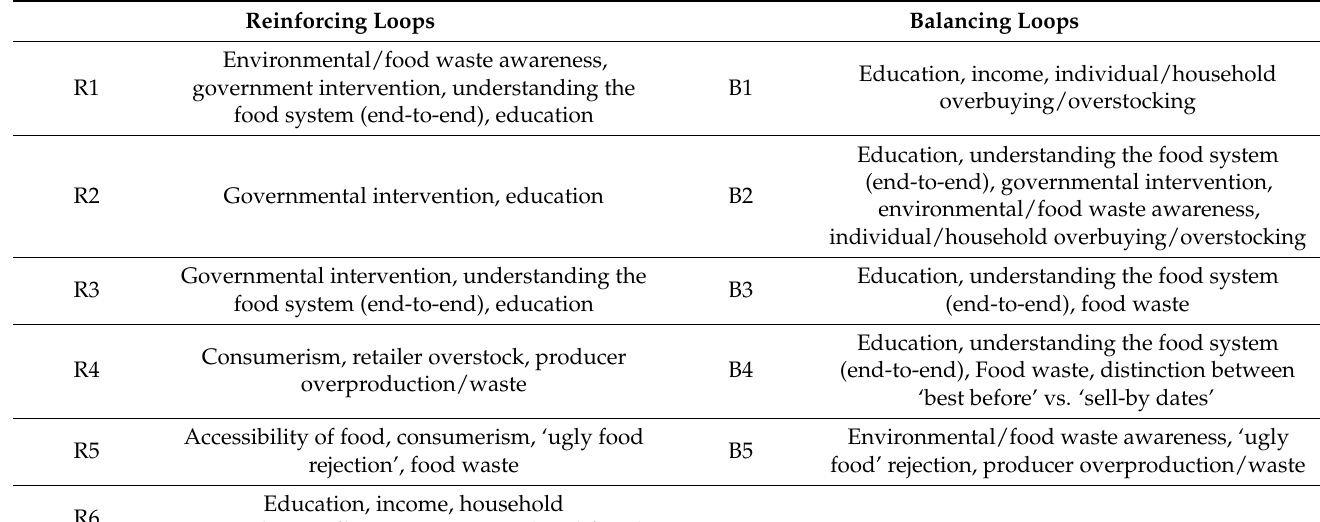
Table 2. Reinforcing and balancing loops from the food waste loop